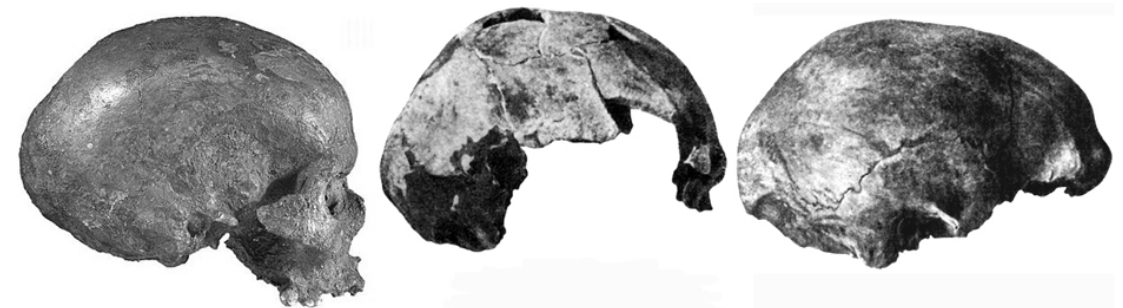
Figure 4. Mlade č 1, 6 and 5, Czech Republic, showing the striking morphological differences between the two females on the left and the male on the right. (To facilitate comparison, all specimens are shown facing the same